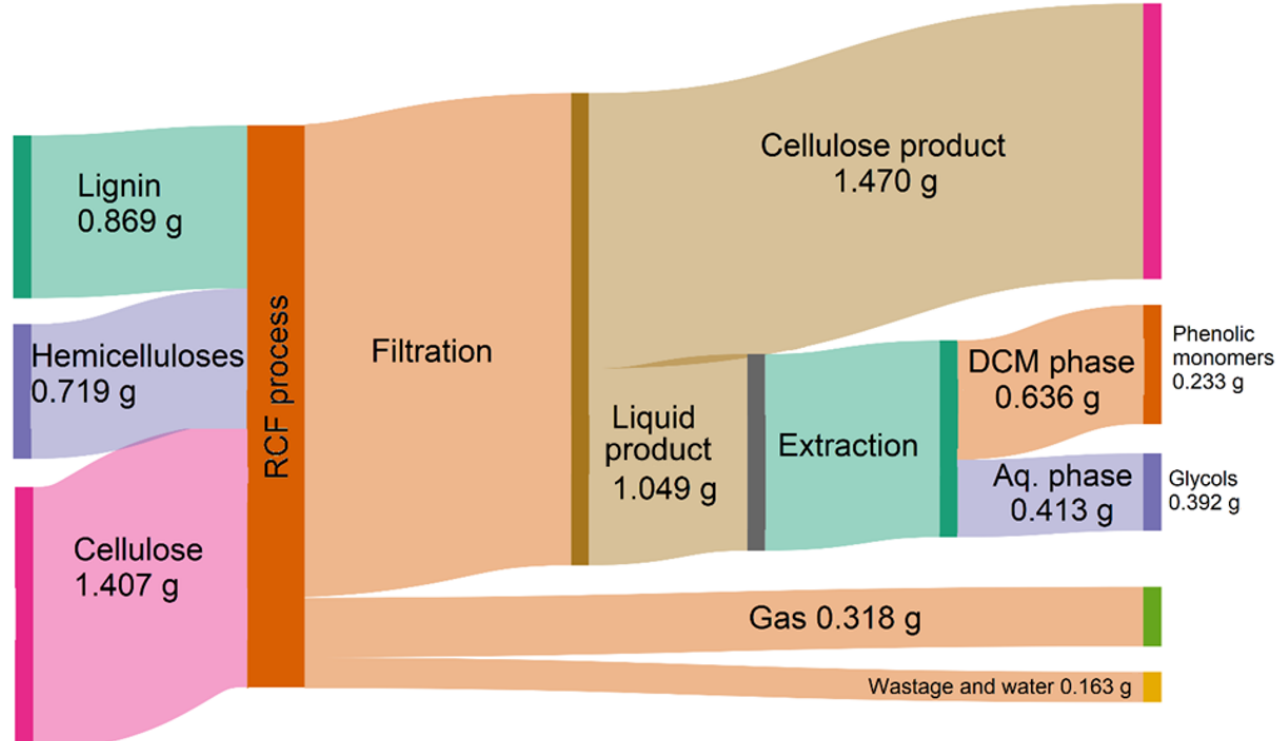
Figure 17. Sankey diagram for the material balance of the reductive catalytic fractionation of spruce wood over the 3RS450 catalyst.